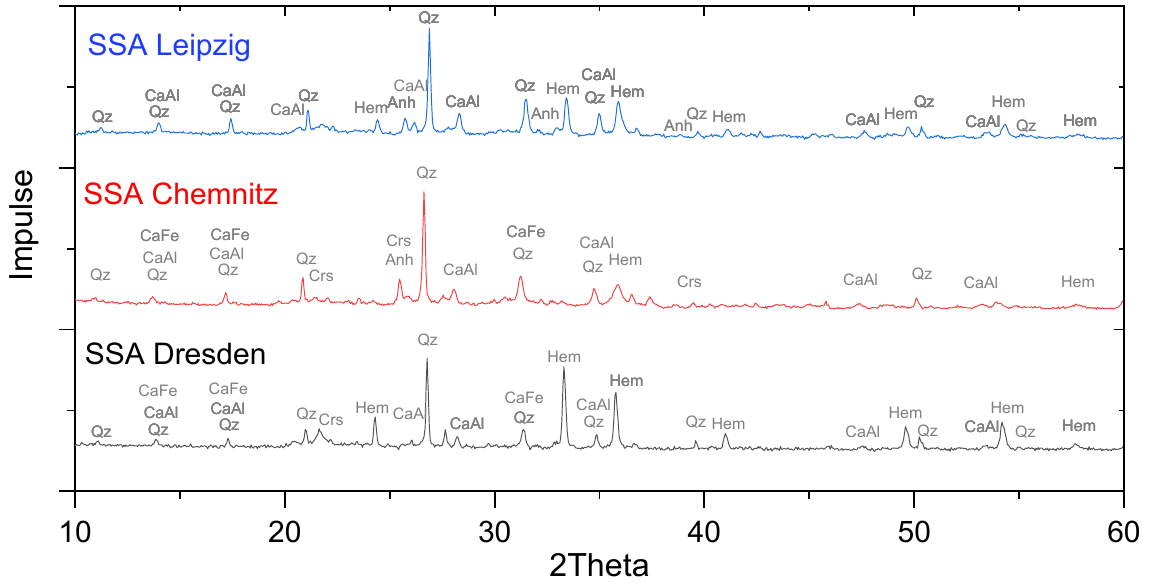
Figure 2. XRD diffractograms of samples. Complete with peak interpretation. Note that amorphous mound has been deleted. Qz: Quarz (SiO 2 ); CaAl: Ca 9 Al(PO 4 ) 7 ; Hem: Hematite (Fe 2 O 3 ); Anh: Anhydrite (CaSO 4 ); CaFe: Ca 9 Fe(PO 4 ) 7 ; Crs: Cristobalite high (SiO 2 ). Table 2. XRD-detected phases and their quantification in MLA, the latter values are sums of data that can be attributed to both quartz and cristobalite high